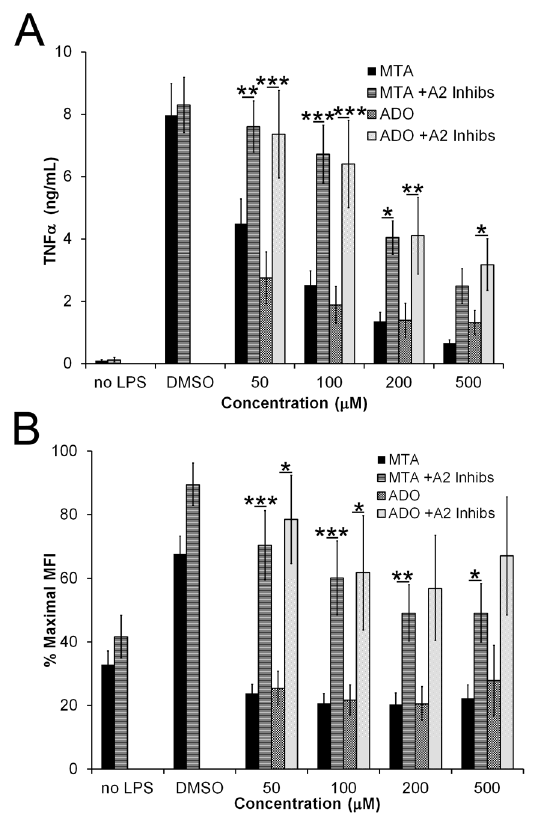
Figure 3. MTA inhibition of TLR ligands acts via Adenosine Receptors. BMDM were incubated overnight with DMSO, the indicated concentrations of MTA or adenosine (Ado), presence or absence of 10 m M SCH442416 and 10 m M PSB1115 and the presence or absence of 10 ng/mL LPS. Supernatants were analyzed for TNF a production by ELISA (A) while cells were harvested, stained and analyzed for surface CD86 (B) expression by FACS. Data represent mean 6 sem of at least 3 experiments. * p , 0.05, ** p , 0.01, *** p , 0.001.